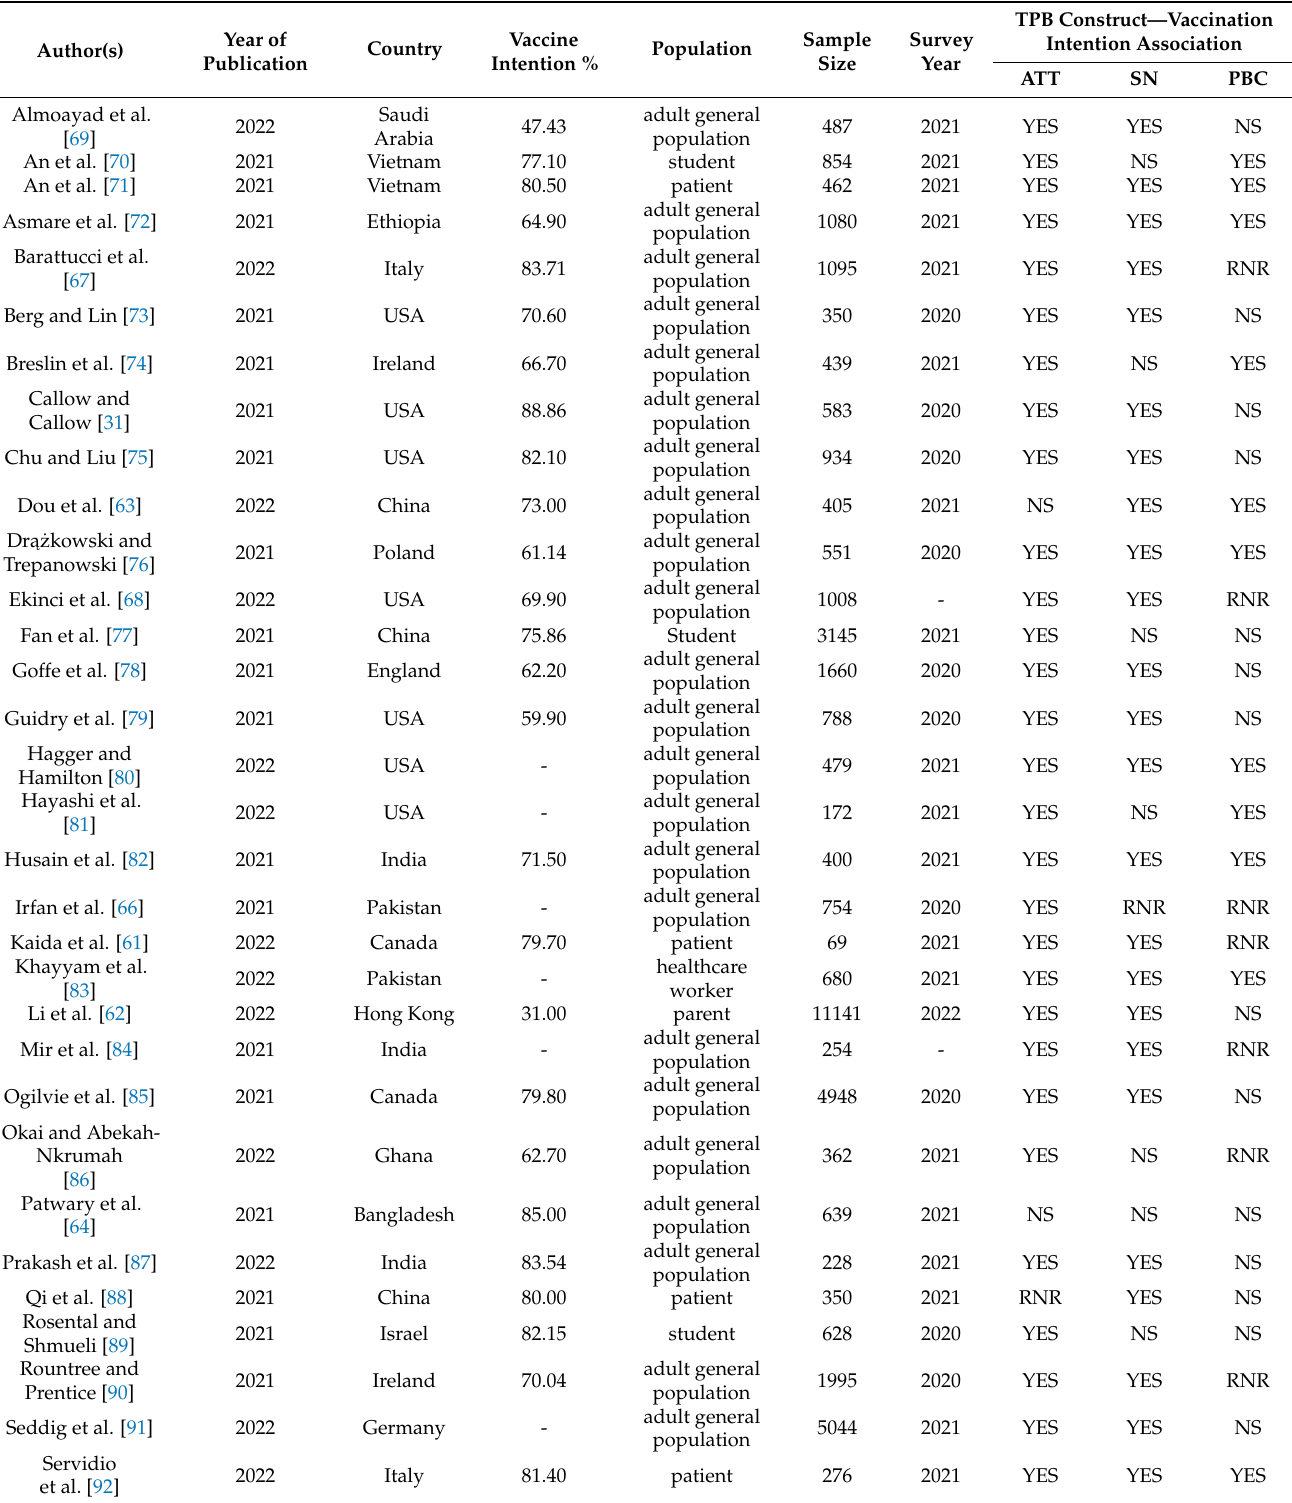
Table 2. Study Characteristics and TPB Constructs Influencing COVID-19 Vaccination